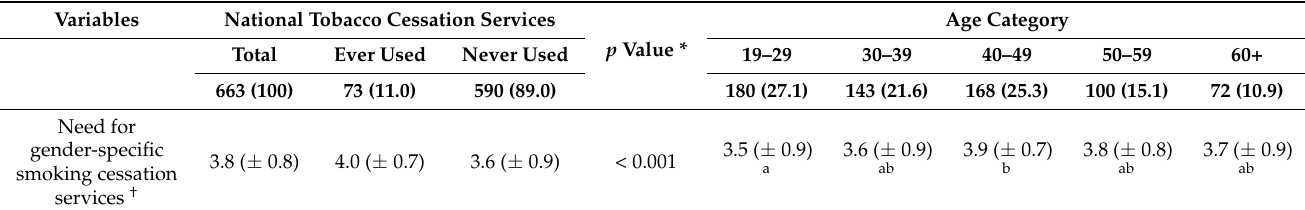
Table 5. The survey participants’ need for gender-specific smoking cessation services ( n =